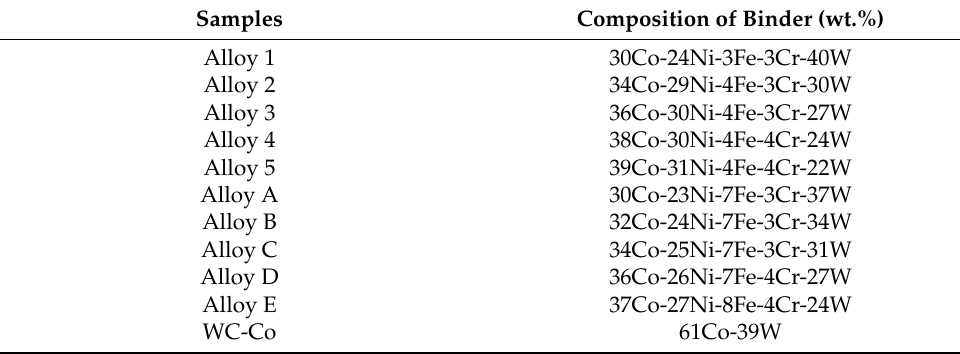
Table 3. Binder composition in different